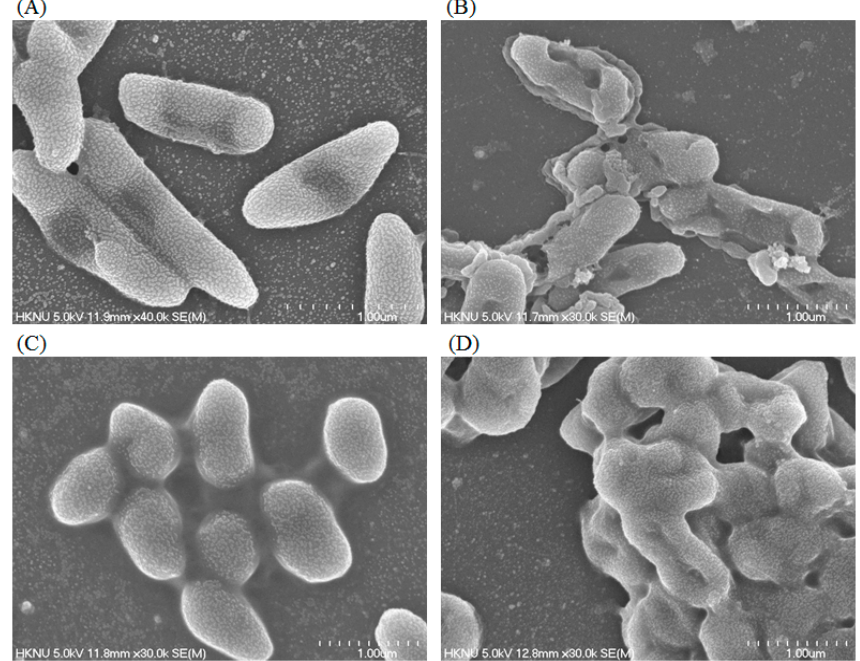
Figure 10. Minimum bactericidal concentration (MBC) of synthesized AgNPs against P. aeruginosa ( A ) and S. aureus ( B ).